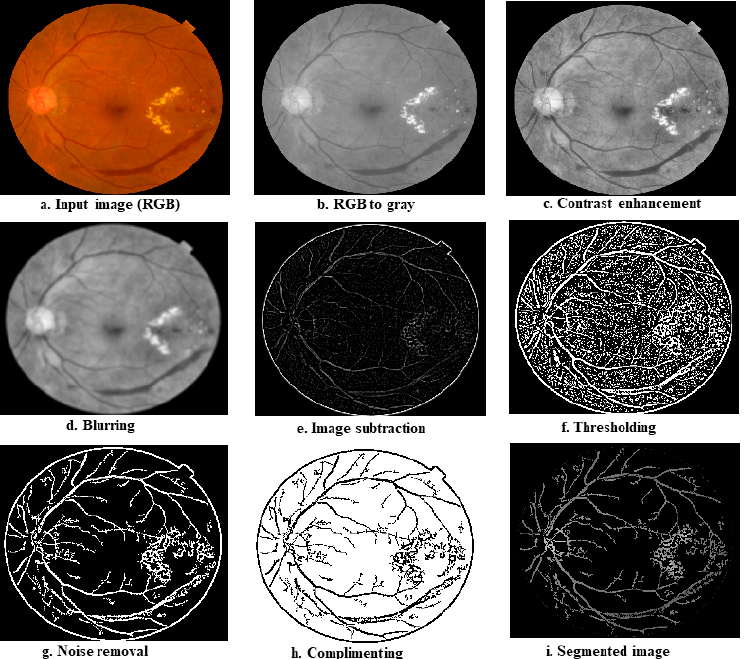
Figure 10 . Transformations of input image (DR fundus) at various stages of the segmentation algorithm. ( a ) shows a sample image from the DR class; ( b ) depicts a gray version of the image; ( c ) provides the image after contrast enhancement operation; ( d ) is the image after averaging operation; ( e ) is the image after subtraction; ( f ) is the image after thresholding operation; ( g ) is the image after noise removal; ( h ) is the image after complementing operation; and ( i ) is the segmented image.